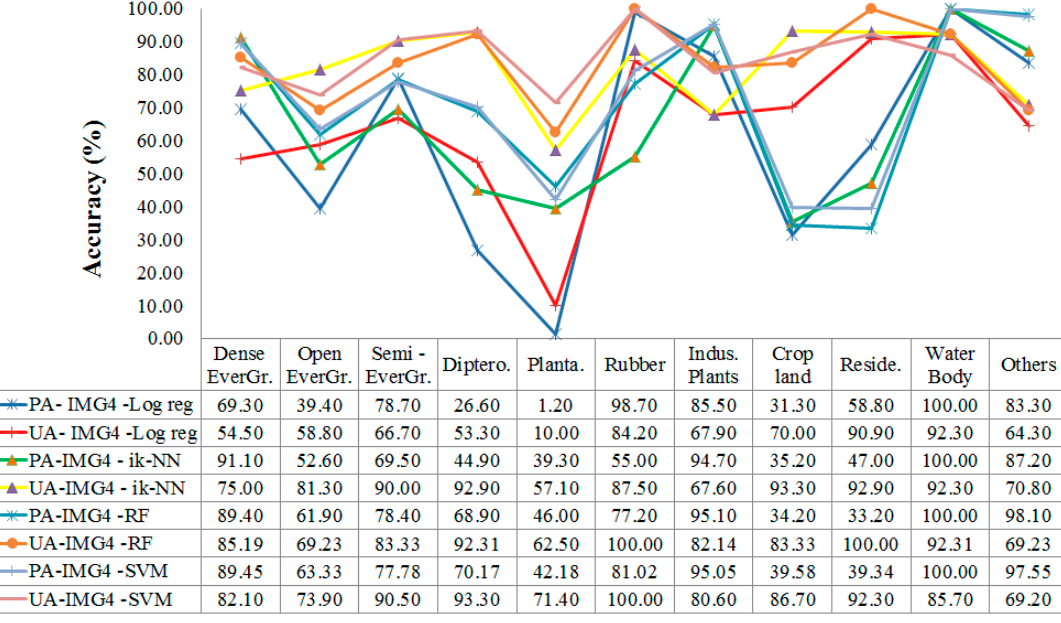
Figure 9. User’s and producer’s accuracies by class for the four classifiers using the IMG 4 combination of the rainy and dry Sentinel 2 satellite imagery.